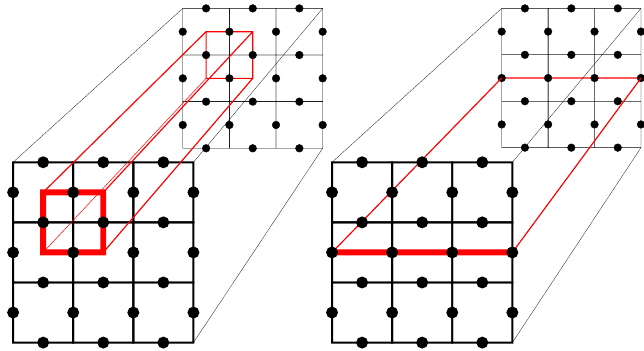
Figure 5: Illustration of non-local tube and plane operators assuming periodic bound- ary conditions. Left: Tube operators, which correspond to the action of X along a straight line. Right: Plane operators, which correspond to the action of σ x sites in the indicated